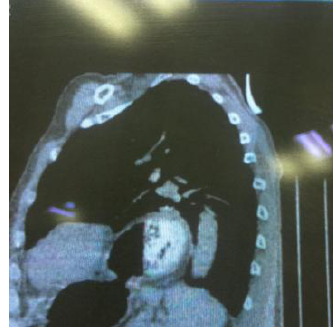
Figure 4. Chest X-ray of patient after surgical repair of hiatal